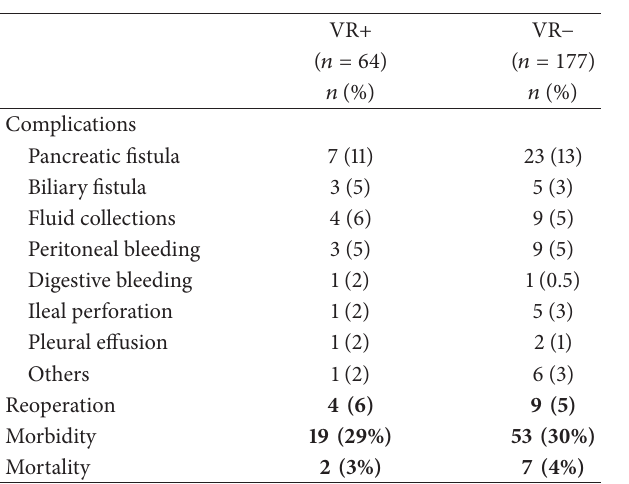
Table 2: Postoperative outcome of patients after pancreatic resec- tion with (VR+) and without (VR − ) vascular resection.